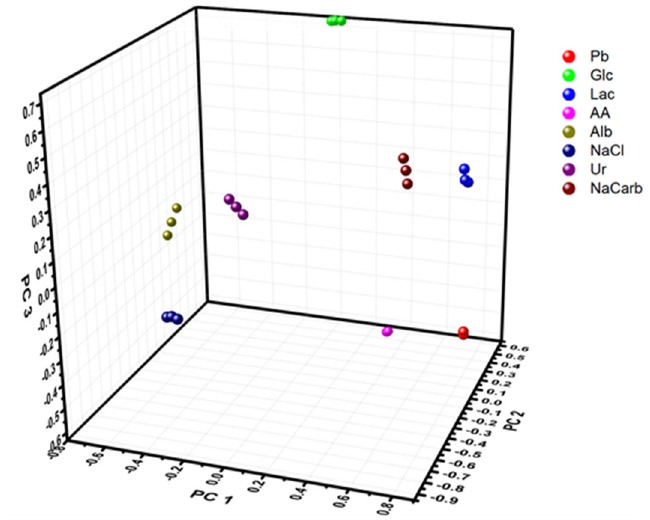
Figure 2. PCA score plot of three different repeat measurements using a macro e-tongue (Device 1) in PB spiked with different metabolites; 5 mM glucose (Glc), 10 mM lactate (Lac), 100 µ g ml − 1 ascorbic acid (AA), 10 mg mL − 1 albumin (Alb), 150 mM sodium chloride, 10 mM urea (Ur) or 100 mM sodium bicarbonate (NaCarb). Explained variance of PC 1 (37.2%), PC 2 (19.1%), and PC 3